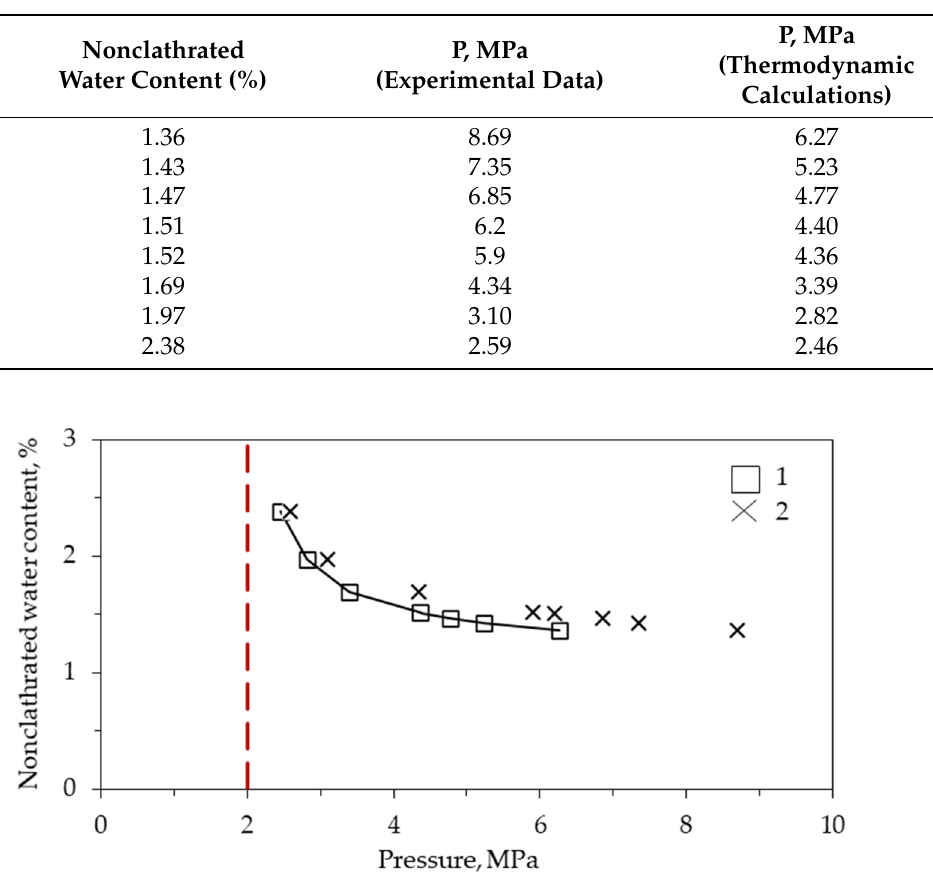
Figure 2. Change in nonclathrated water content depending on methane pressure in kaolinite clay at a temperature of 265.65 K. Calculated data represented by squares—1. Crosses, experimental data—2. Solid line—approximation of calculated data; red line—equilibrium “ice–methane–hydrate” at a temperature of 265.65 K.